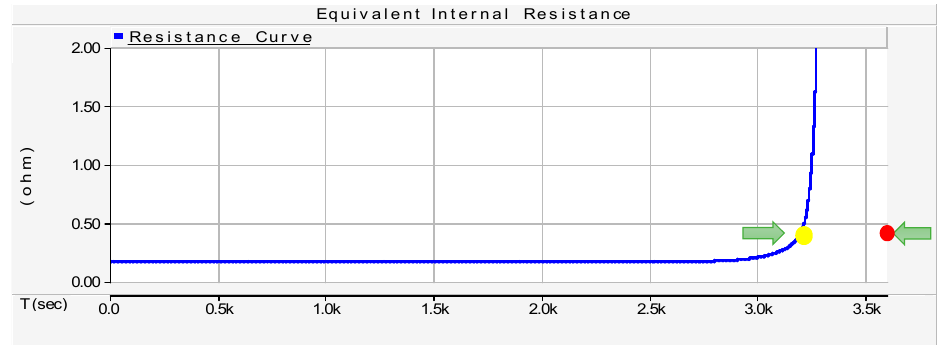
Figure 2. Change of internal resistance to decrease in SOC along time axis.